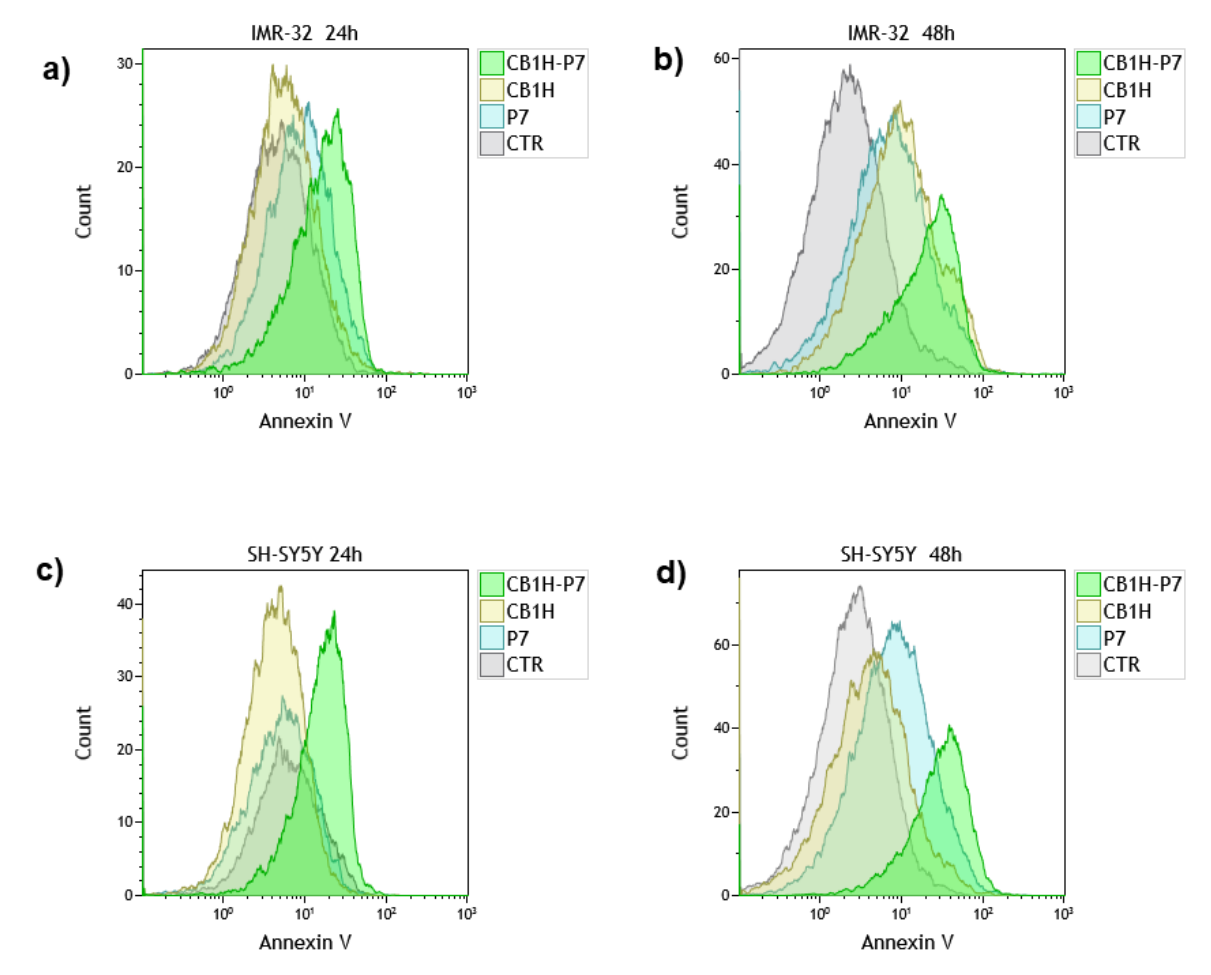
Figure 4. Distribution of Annexin-V-negative (Annexin-V intensity < 10 1 ) cells (living cells) and Annexin-V-positive (Annexin-V intensity > 10 1 ) cells (apoptotic cells) in IMR-32, and SHSY 5Y cells untreated (CTR) and treated with CB1H, P7 and CB1H-P7 NPs for 24 ( a , c ) and 48 h ( b , d ),